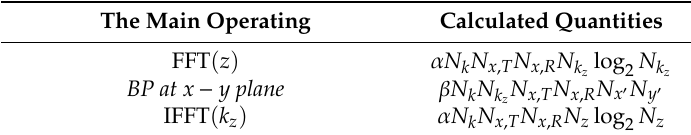
Table 3. Computation complexity for main steps of the proposed